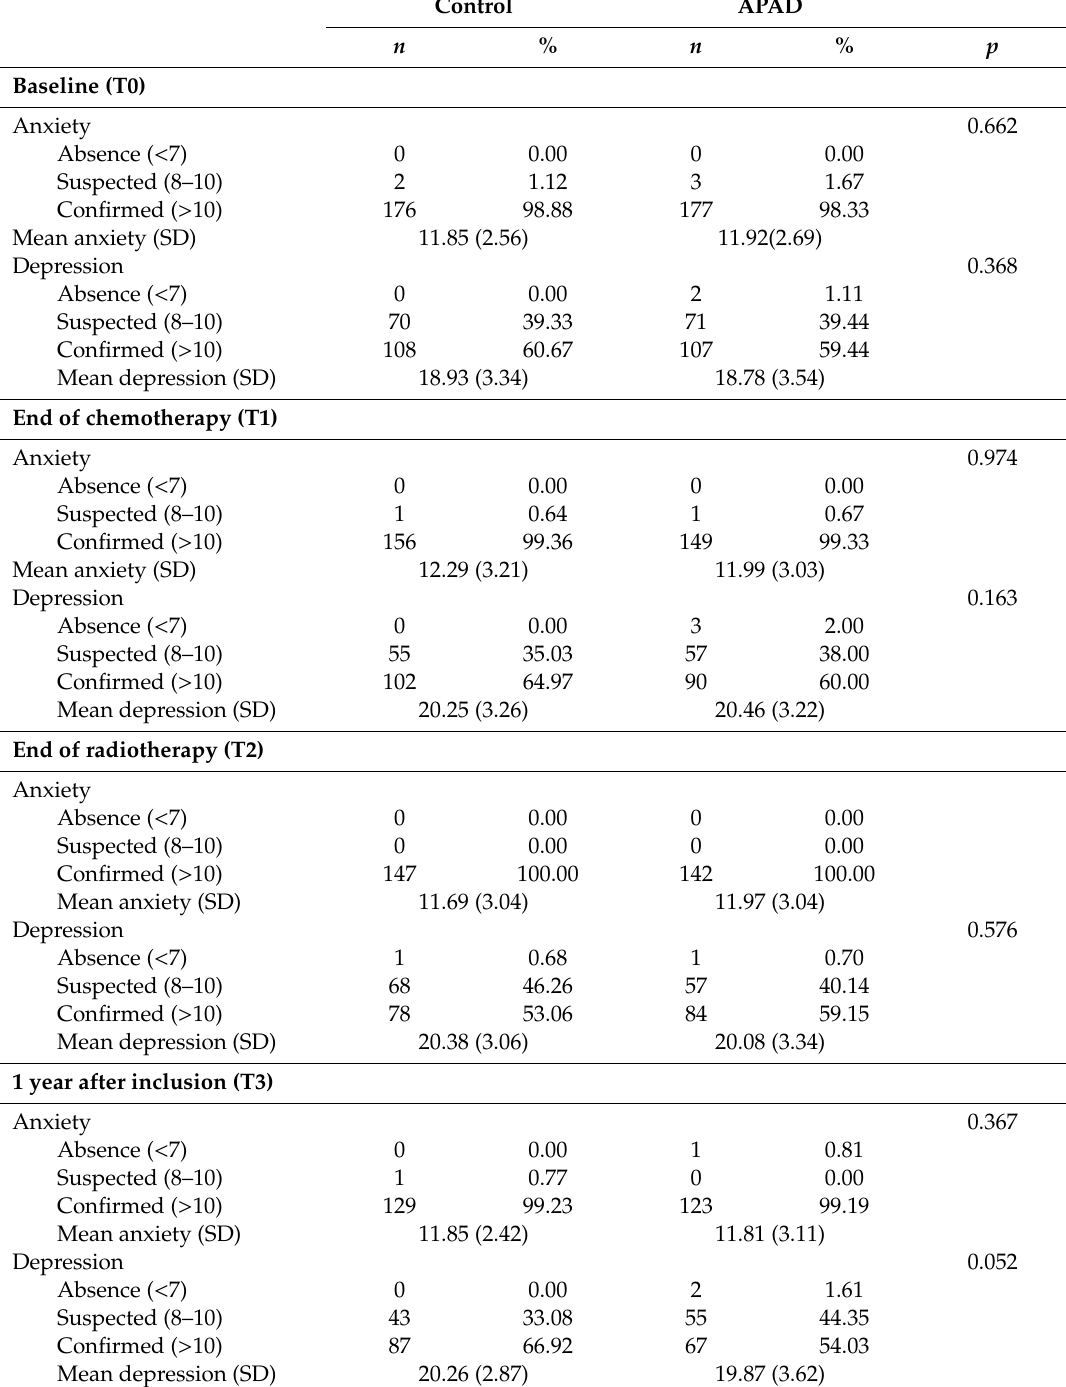
Table 3. Anxiety and depression disorders in the intention-to-treat